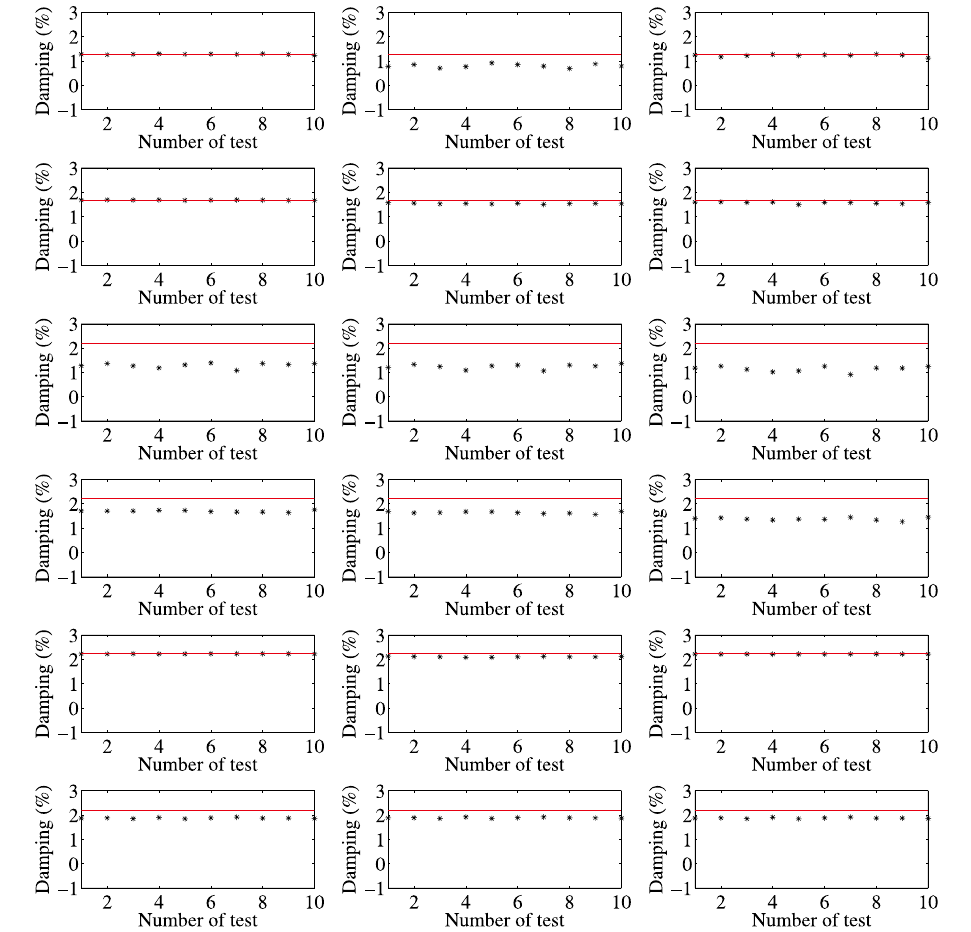
Fig. 8. Damping estimates based on (left) FRFs (middle) Power Spectra based OMAX (right) Transmissibility based